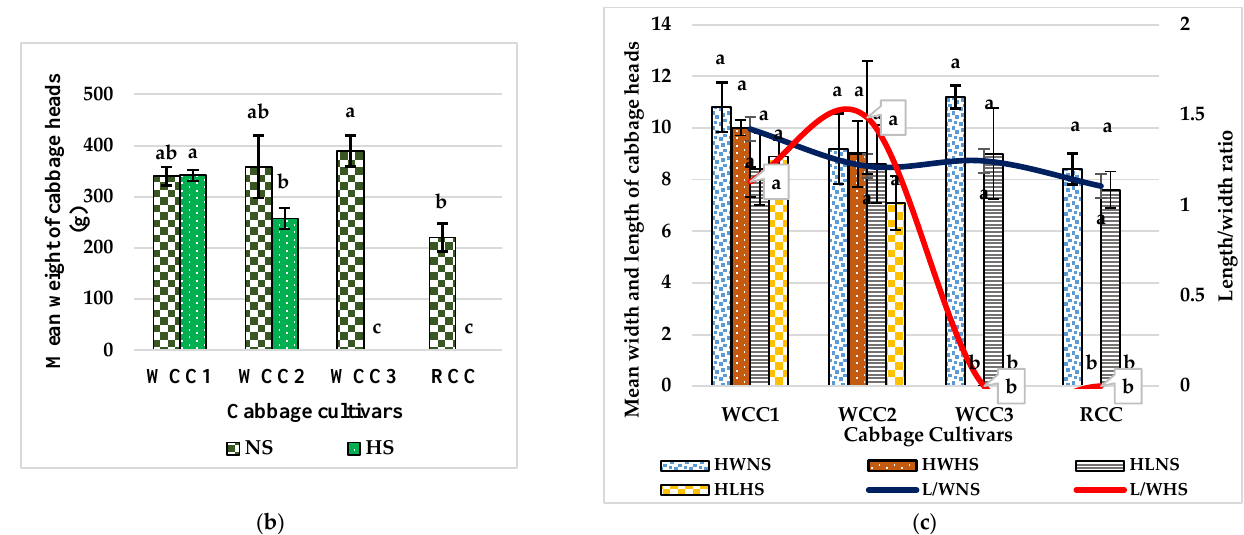
Figure 1. Effects of heat stress (HS) on morphological characteristics of different cabbage cultivars. Comparison of ( a ) HS phenotype of cabbage head formation, ( b ) mean head weight and ( c ) mean head width, length and their ratios. Bars denote the mean ± SE ( n = 5). Mean values within each cultivar with different letters are significantly different based on Tukey’s HSD test at p < 0.05.